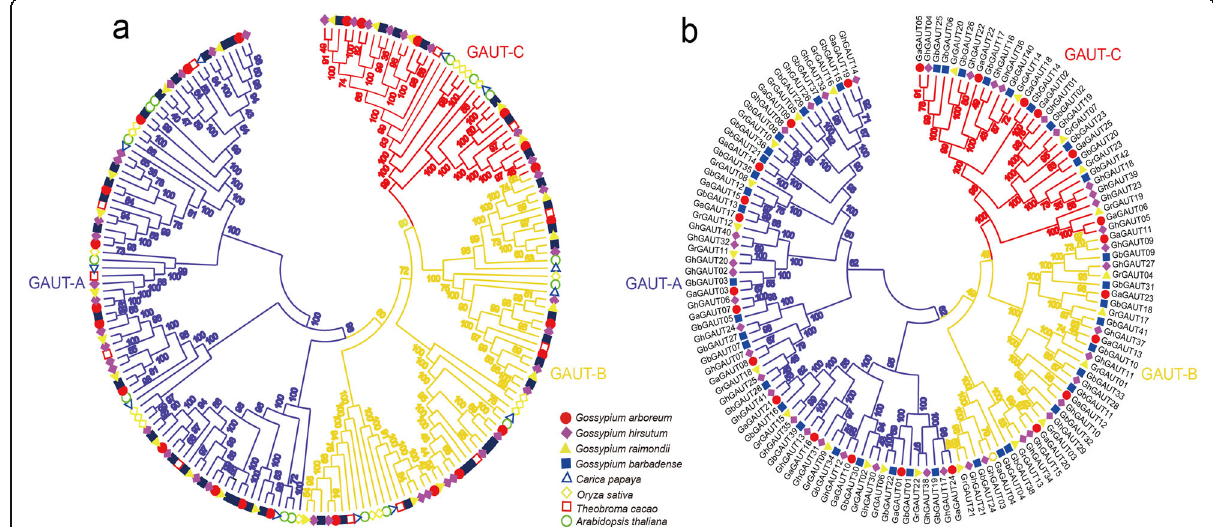
Fig. 1 Phylogenetic tree of the galacturonosyltransferase (GAUT) gene family a. Neighbor-joining phylogenetic tree of galacturonosyltransferase (GAUT) genes from eight species. b: Neighbor-joining phylogenetic tree of galacturonosyltransferase (GAUT) family form the four cotton species. They comparised three types of protein sequences by multiple sequence alignment of the 187 GAUT proteins for eight species. From the four cotton species, GAUT gene family were classified into GAUT-A (62 proteins), GAUT-B (38 proteins), and GAUT-C (31